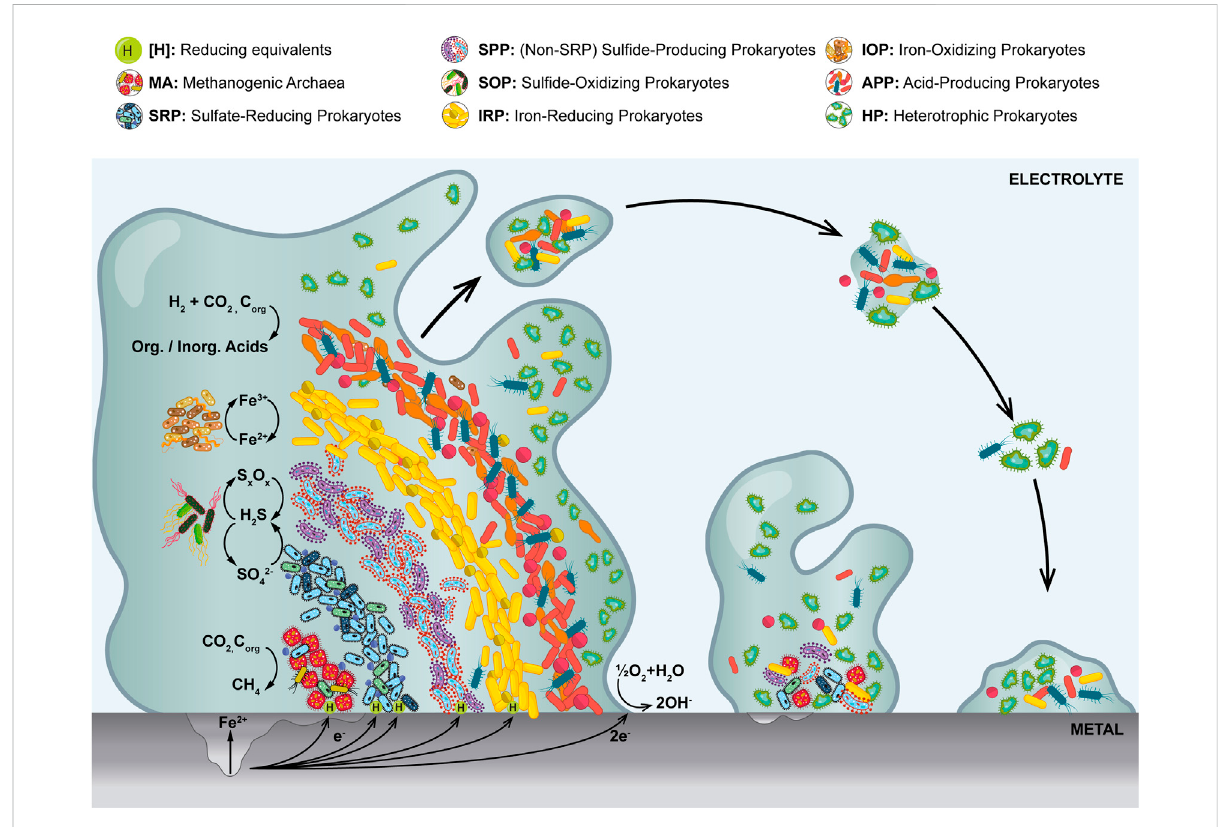
FIGURE 1 Representation of a strati fi ed multispecies bio fi lm at different stages of development on a corroding metal surface. Most relevant microbial groupsaredepictedinanidealizedredoxzonationfromtheoxidizedouterlayerstothemoreanaerobicinnercore.Onlythemostrepresentativehalf reactions are